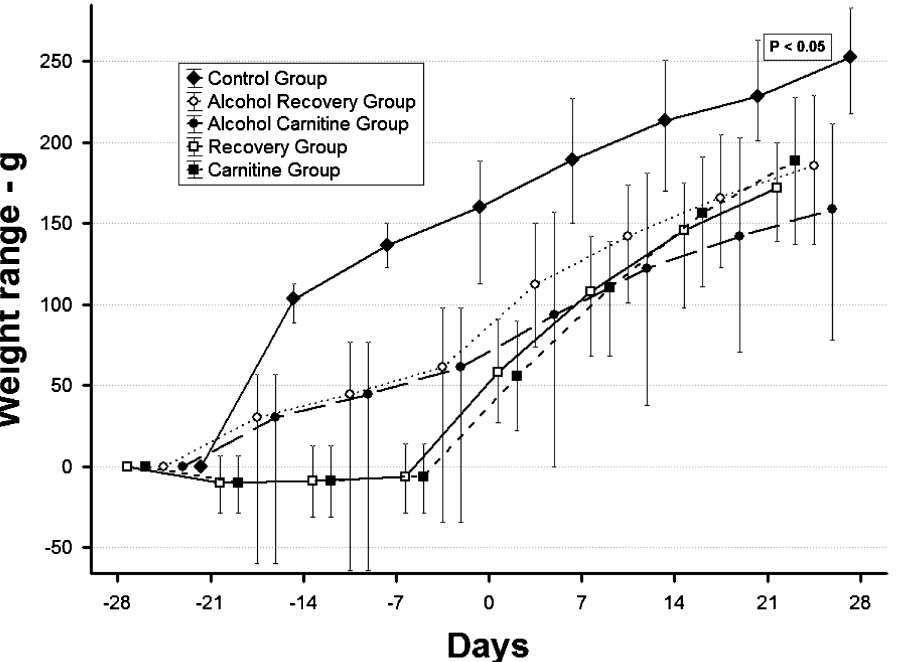
Figure 2 – Mean, minimum, and maximum variation in weight during the experimental protocol in relation to baseline. Control animals ingesting an ad libitum diet throughout the experiment. Alcohol recovery malnourished animals re-fed with an ad libitum diet, no alcohol. Alcohol Carnitine recovery malnourished animals re-fed with a carnitine-supplemented, ad libitum, no alcohol. Recovery malnourished animals re-fed with ad libitum diet. Carnitine malnourished animals re-fed with a carnitine- supplemented diet,